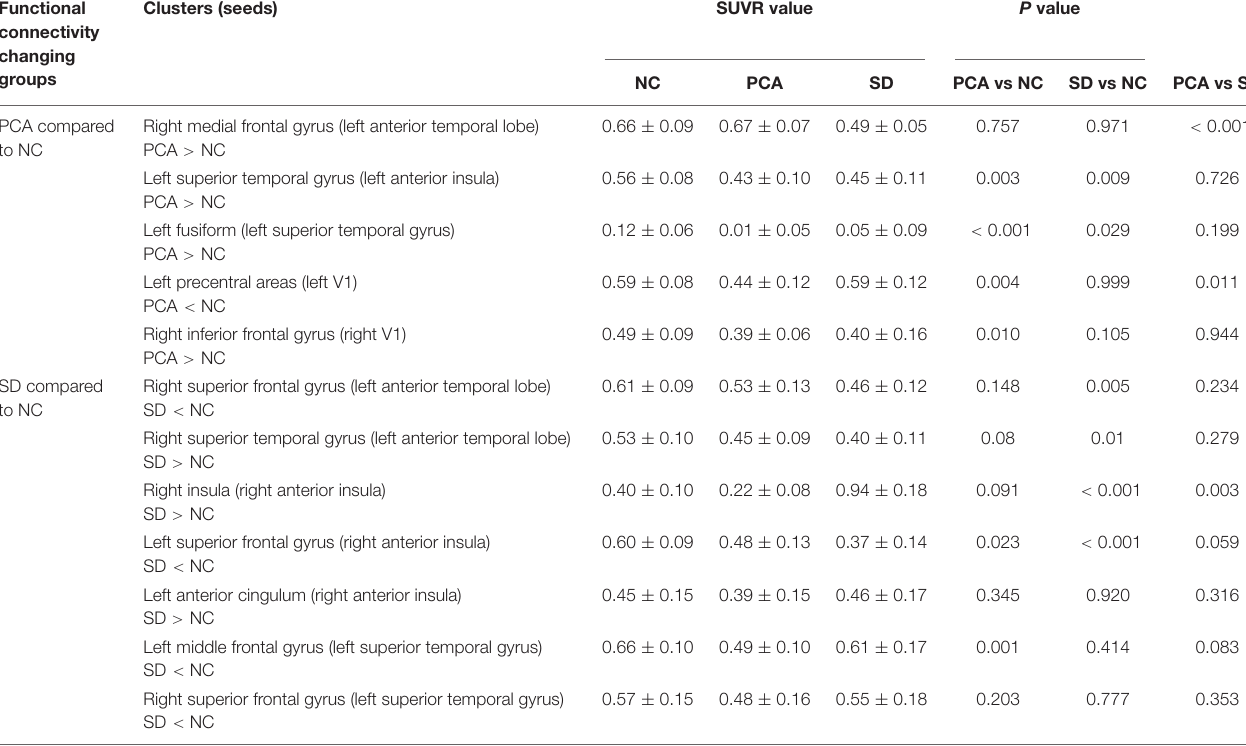
TABLE 5 | Averaged 18 F-FDG SUVR in cluster with abnormal connectivity to seed in normal controls and patients with PCA and SD. Functional connectivity changing